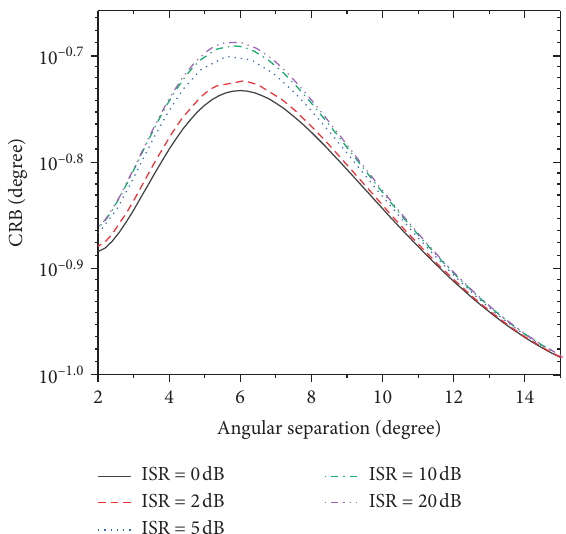
Figure 4: The CRBs of the weak source against SNR ferent ISRs.